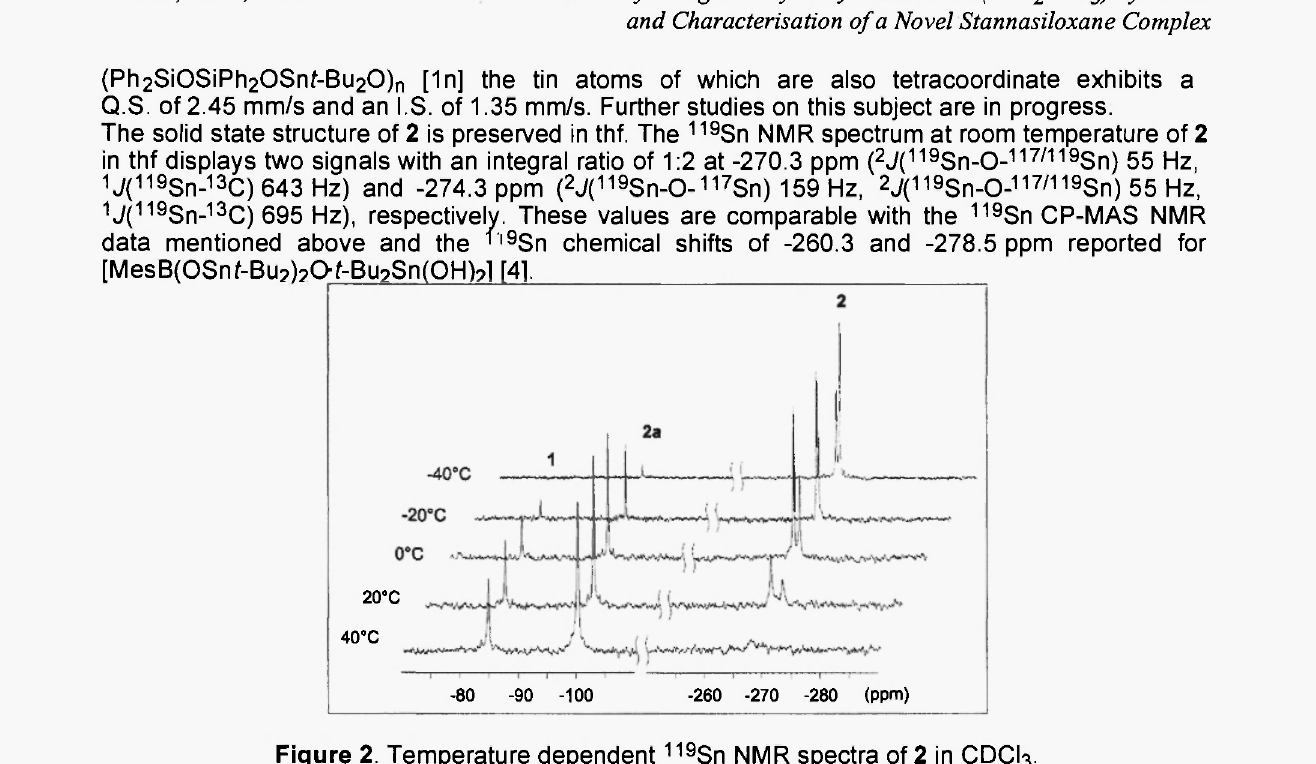
Figure 2. Temperature dependent 119 Sn NMR spectra of 2 in